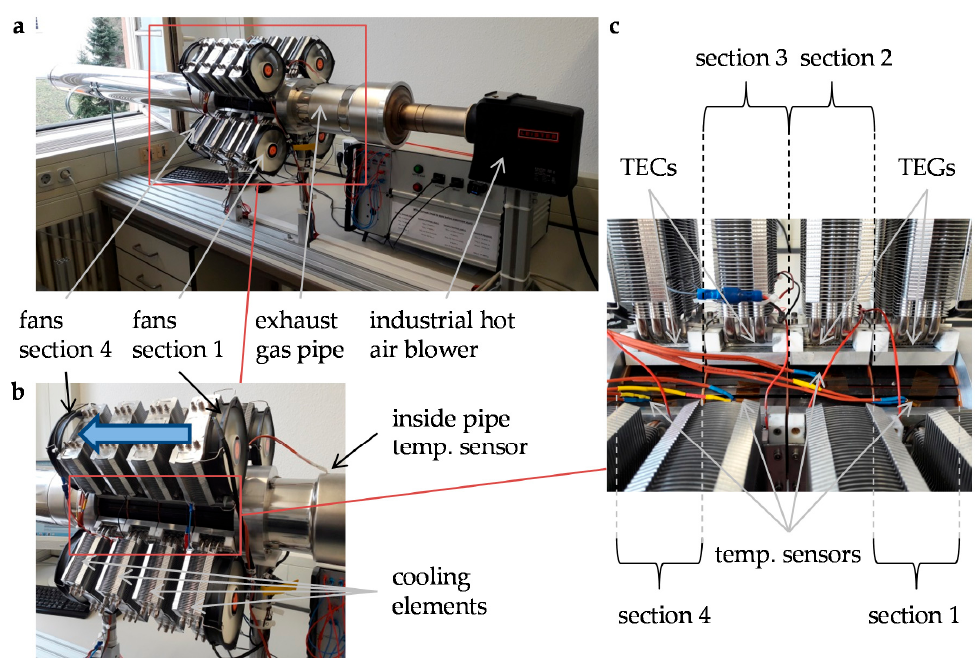
Figure 6. Heating mockup with attached thermoelectric energy harvesting systems (EHS); ( a ) shows the complete setup; ( b ) shows an enlargement of a partial excerpt of ( a ); ( c ) shows an enlargement of a partial excerpt of ( b ).